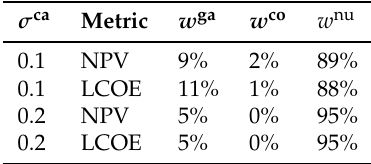
Table 15. The composition of minimum CVaRD portfolios: The three-asset